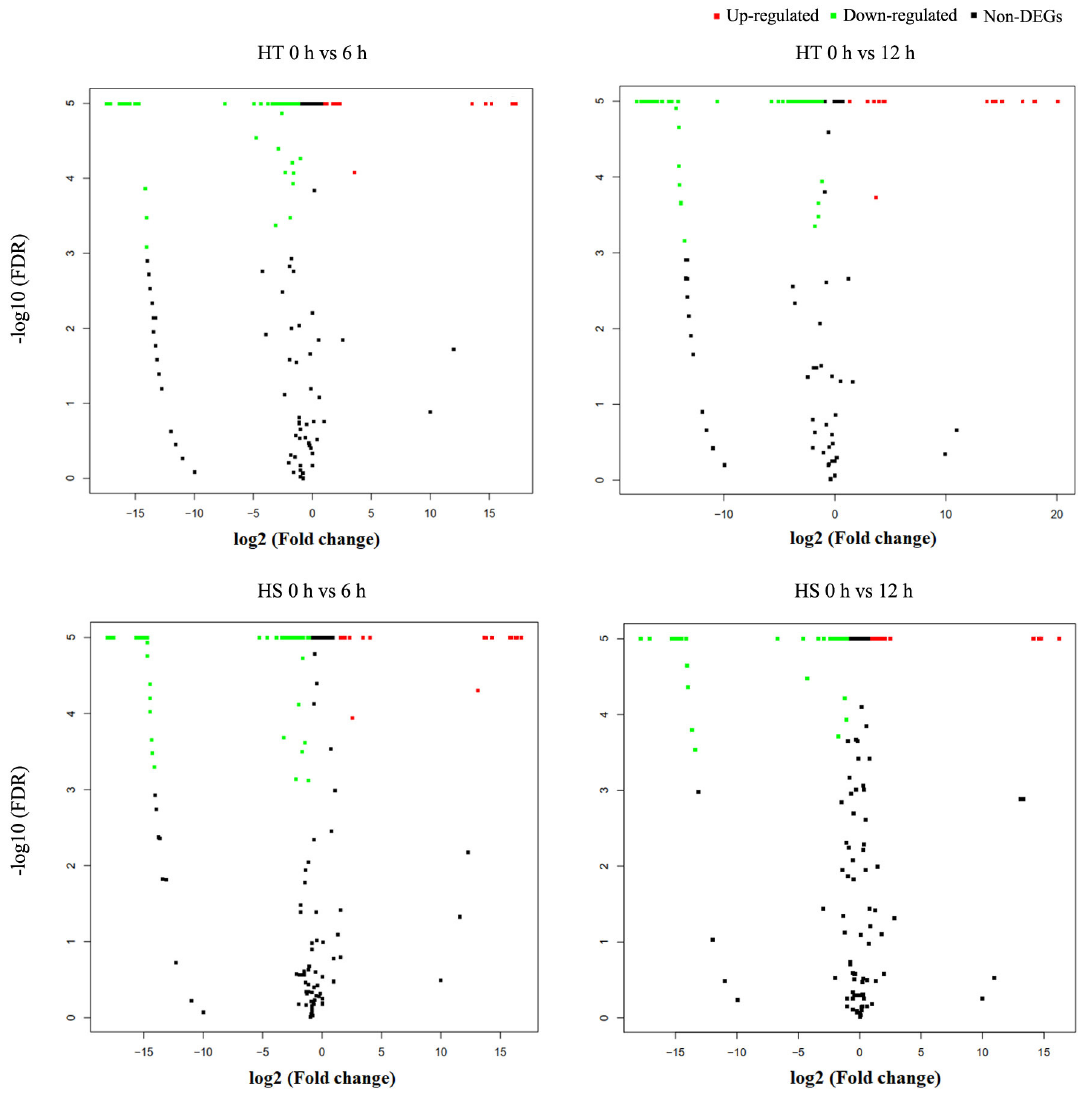
Figure3. Di ff erentialexpressionofheatresponsivemiRNAsinheat-tolerant(HT)andheat-sensitive(HS) Figure 3. Differential expression of heat responsive miRNAs in heat-tolerant (HT) and heat-sensitive genotypes of flowering Chinese cabbage. Non-DEGs refer to miRNAs with non-di ff erential (HS) genotypes of flowering Chinese cabbage. Non-DEGs refer to miRNAs with non-differential expression.